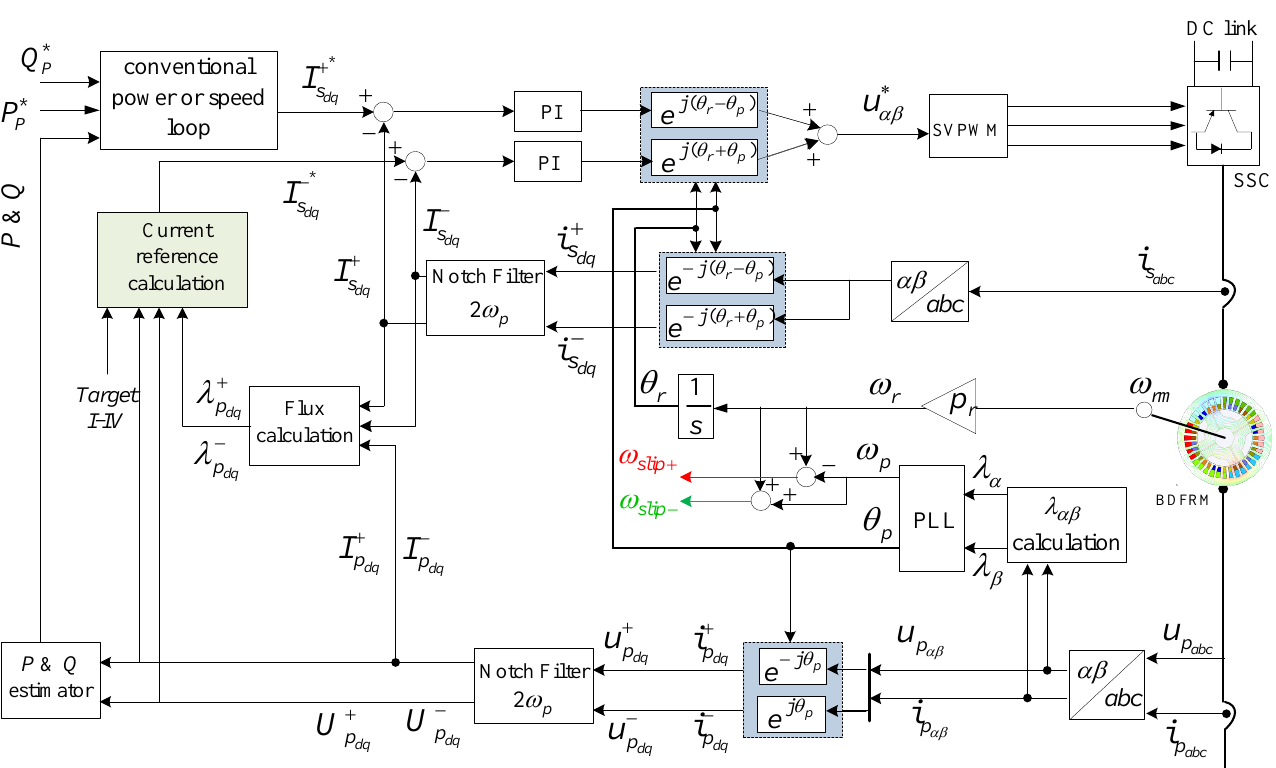
Figure 7. A block diagram of the proposed control strategies under unbalanced grid voltage conditions (sign "*" denotes reference values).